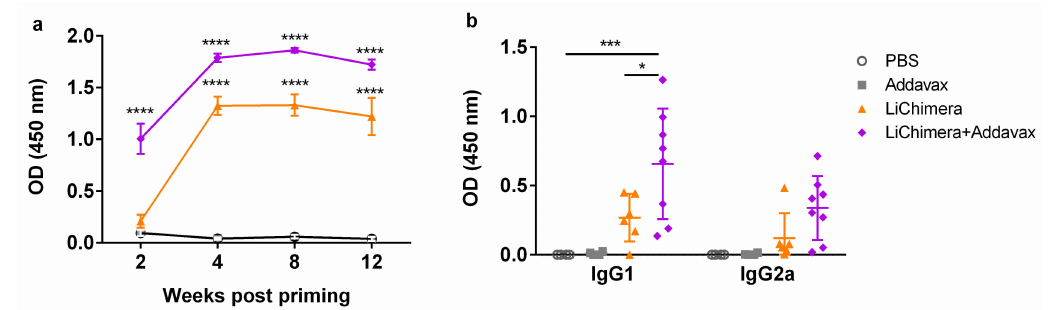
Figure 4. Detection of LiChimera-specific antibodies in LiChimera-vaccinated mice. The BALB / c mice were intramuscularly vaccinated two times at two-week intervals with LiChimera alone or adjuvanted with Addavax. ( a ) Kinetics of the LiChimera-specific serum IgG production on weeks 2, 4, 8, and 12 post priming were determined by ELISA; ( b ) Two weeks post boosting, serum samples were assayed for antigen-specific IgG1 and IgG2a antibodies by ELISA. Data are expressed as means ± s.d. for n = 6 (PBS and Addavax) or n = 8 mice (LiChimera and LiChimera / Addavax). Significant di ff erences between groups are indicated with asterisks measured by one-way ANOVA and Tukey’s multiple comparison tests. * p < 0.05, *** p < 0.001, and **** p <